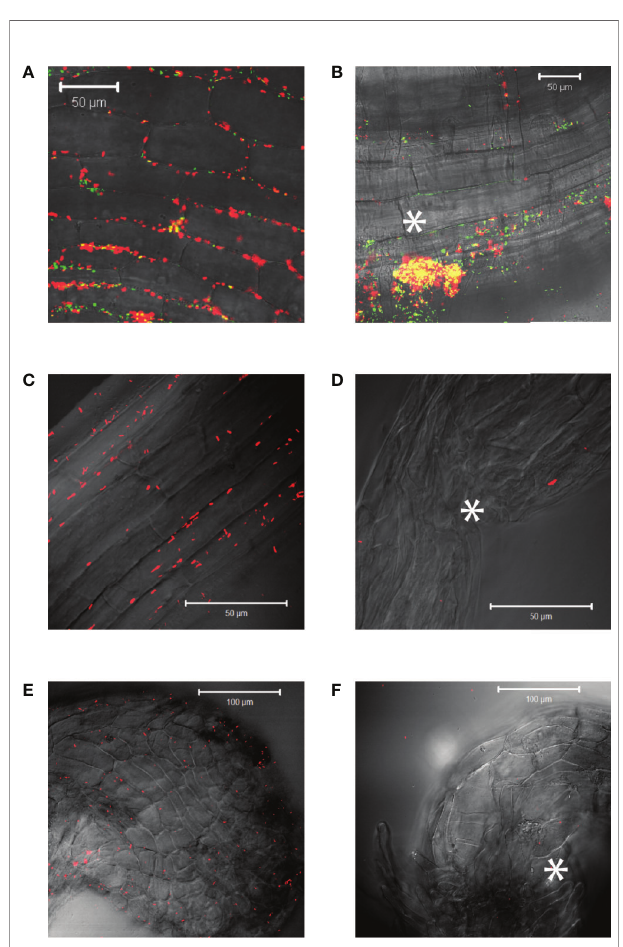
FIGURE 6 | Virulence induction events reveal similarities between young seedlings of different species. Strain YHL324 s+ was co-cultivated with two- week old tobacco seedlings on glycerol plates and an unwounded root (A) and a wounded root (B) are shown. A similar experiment was performed with fi ve-day-old S. asiatica seedlings and YHL324 s+ on glycerol plates and representative images are shown: unwounded root of a fi ve-day-old S. asiatica seedling (C) , a wounded root of a S. asiatica seedling (D) , a haustorium of a S. asiatica seedling (E) , and a wounded haustorium of a S. asiatica seedling (F) . White asterisks indicate approximate